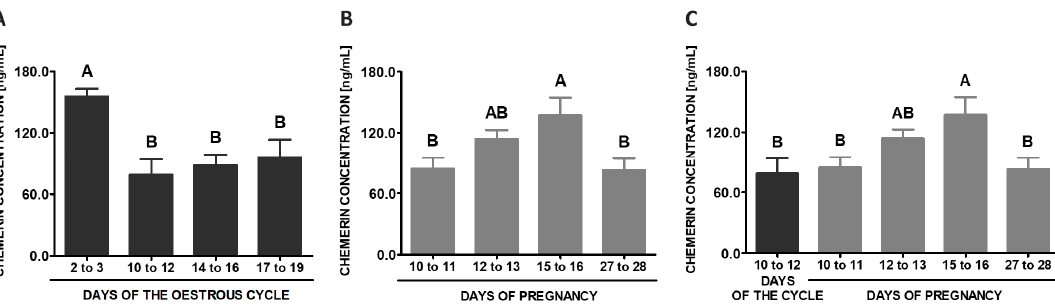
Figure 14. Chemerin concentrations in the porcine blood plasma. Concentrations of chemerin in the porcine blood plasma was determined during the oestrous cycle on days: 2 to 3, 10 to 12, 14 to 16 and 17 to 19 ( A ), during early pregnancy on days: 10 to 11, 12 to 13, 15 to 16 and 27 to 28 ( B ) and compared between early pregnancy and days 10 to 12 of the oestrous cycle ( C ). The hormone content in blood plasma was evaluated using ELISA. Results are presented as means ± SEM ( n = 5). Bars with different superscripts differ (one-way ANOVA at p < 0.05 followed by Tuckey post-hoc test at p < 0.05).